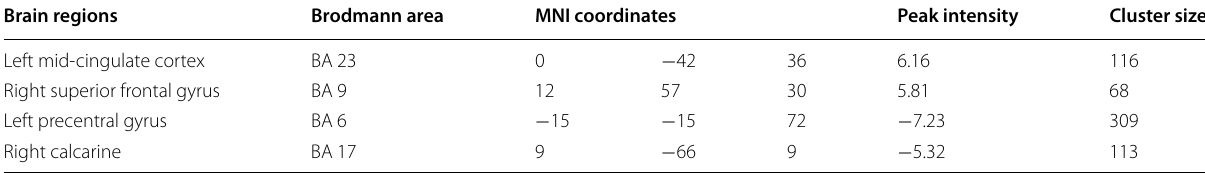
Table 2 The detailed information for ALFF differences between Degenerative Cervical Myelopathy patients and healthy controls Brain